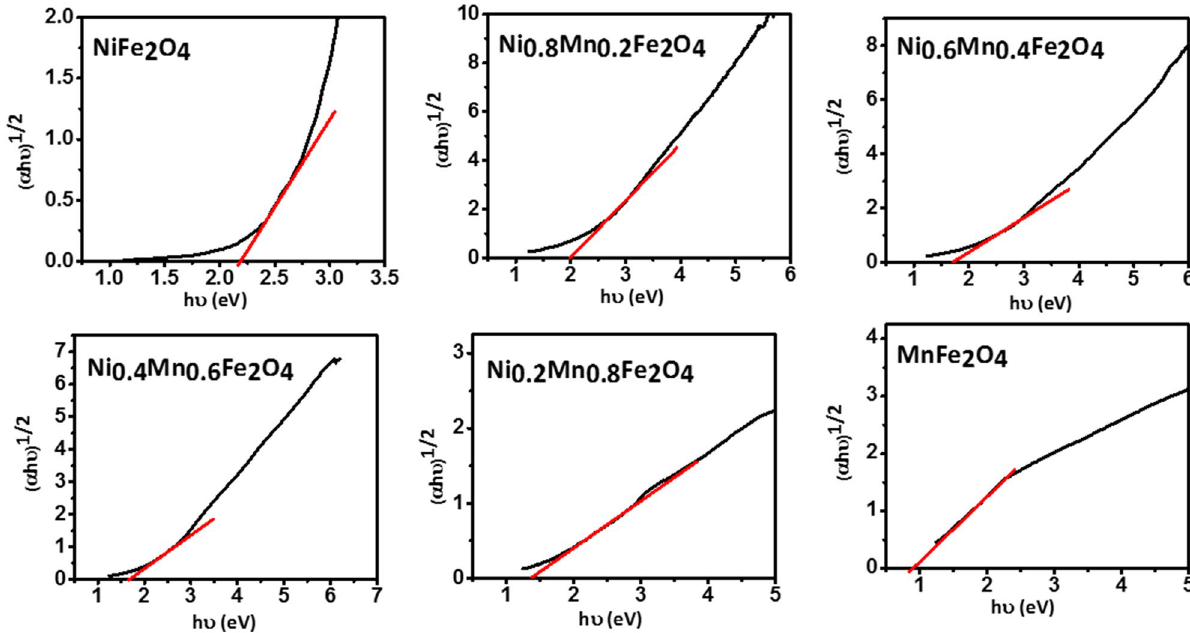
Figure 6. Tauc plots of the Ni 1− x Mn x Fe 2 O 4 nanoparticles assuming indirect bandgaps.